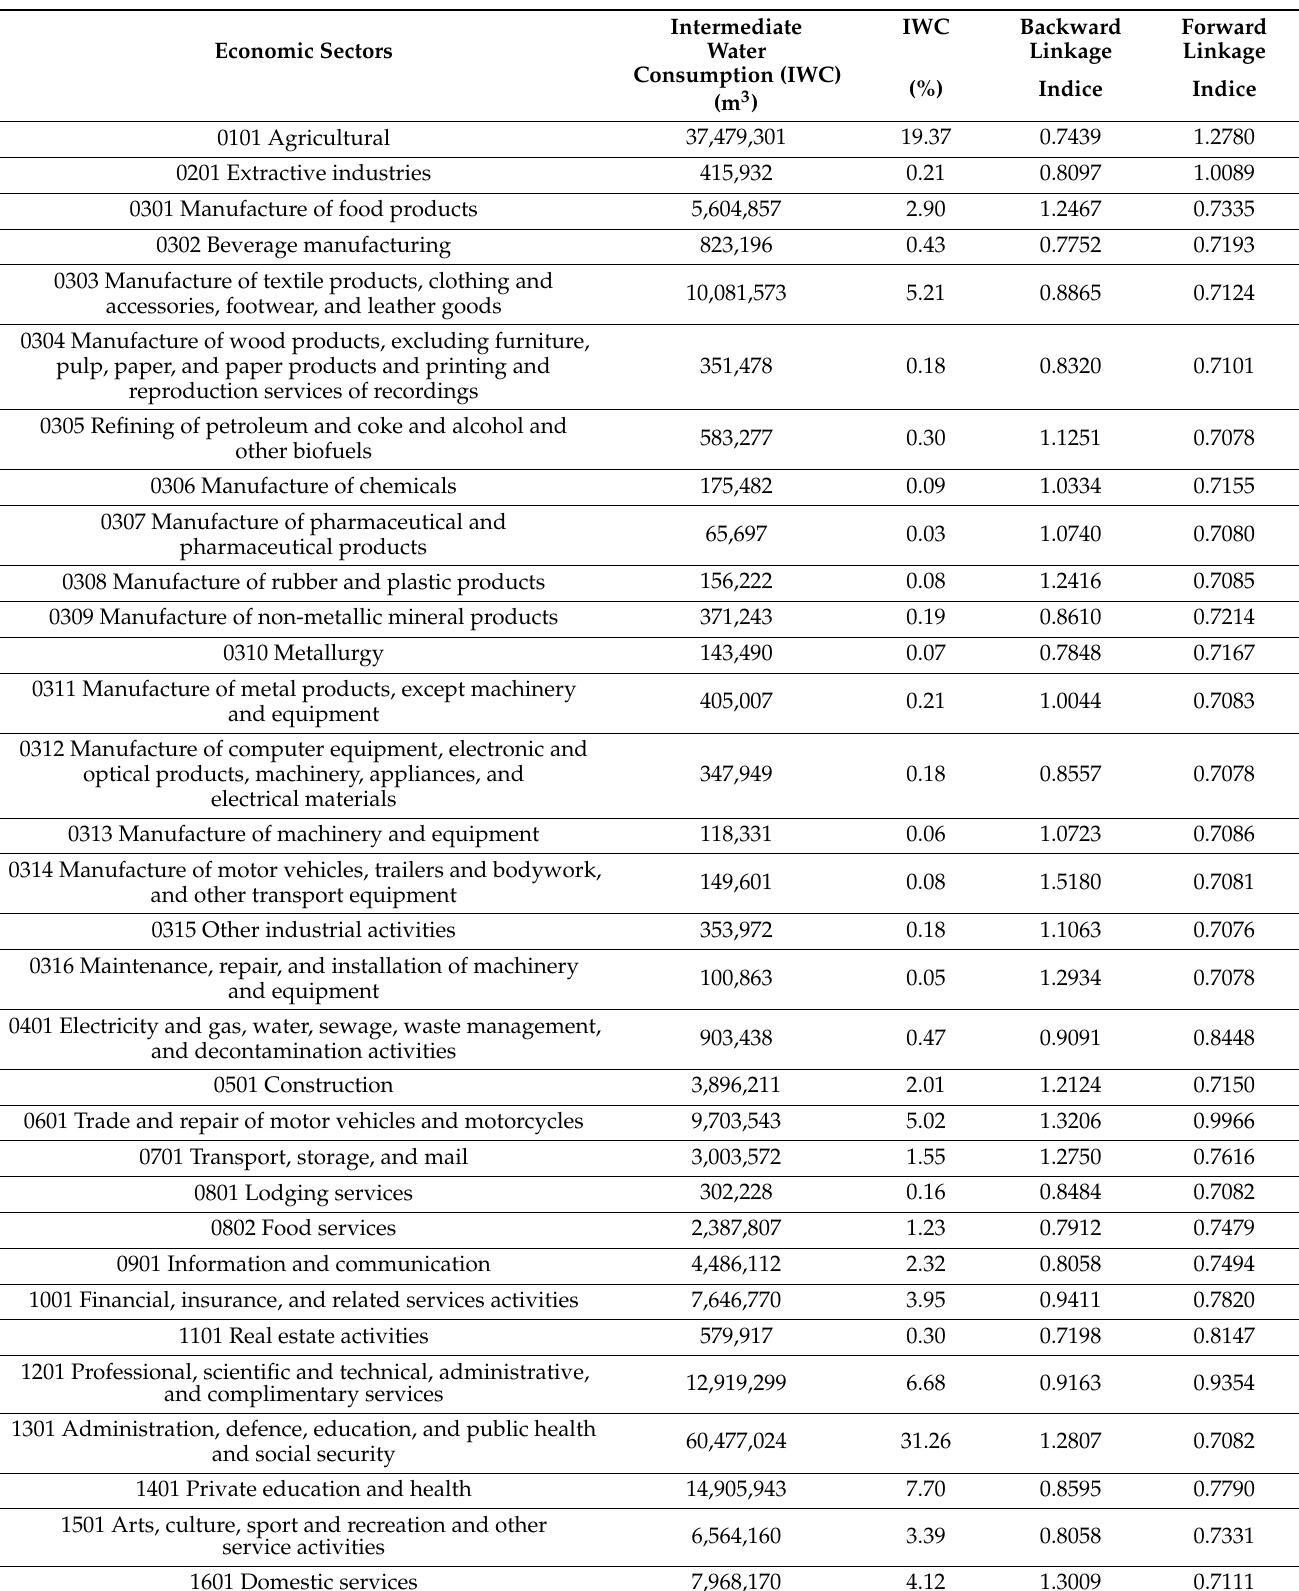
Table A2. Intermediate water consumption, and Rasmussen and Hirschman indices for the Backward, and Forward (Direct, Indirect and Induced Effects) of Water Flows, Cear á